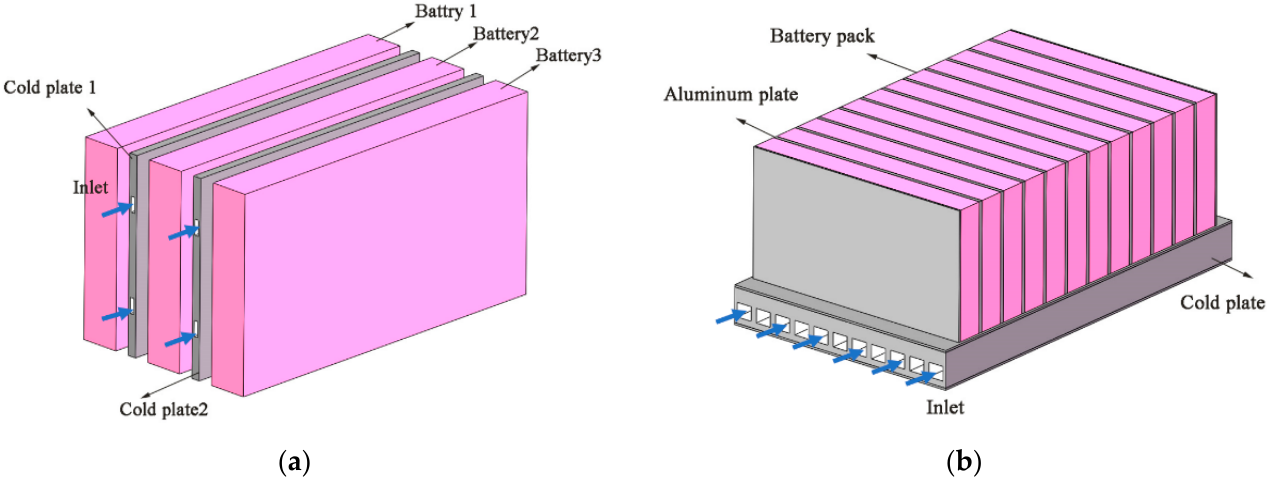
Figure 1. Schematic diagram of ( a ) the side-liquid-cooled BTMS; ( b ) the bottom-liquid-cooled BTMS.